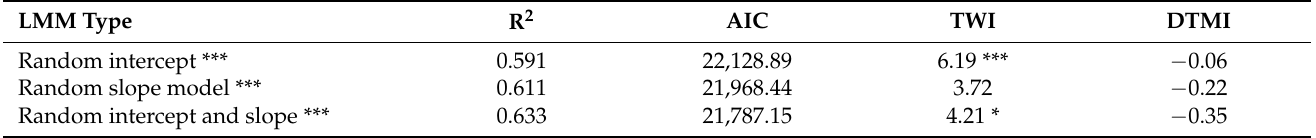
Table 3. The result of the linear mixed model (LMM) with three types of random effects. * indicates the significance of the models and predictors. *** means p -value < 0.001, * means p -value <